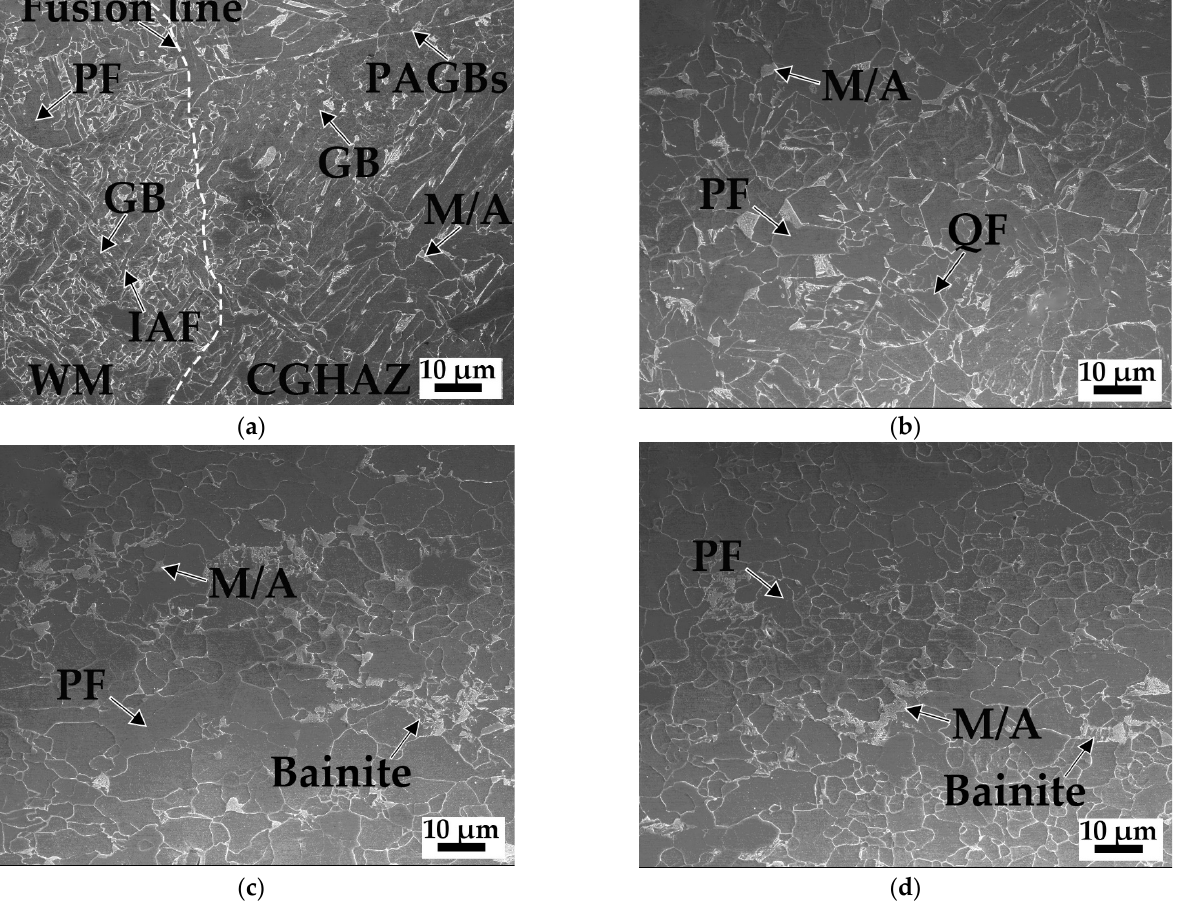
Figure 6. SEM micrographs of HAZ. ( a ) FL between CGHAZ and WM, ( b ) FGHAZ, ( c ) ICHAZ near FGHAZ and ( d ) ICHAZ near SCHAZ. FGHAZ and ( d ) ICHAZ near